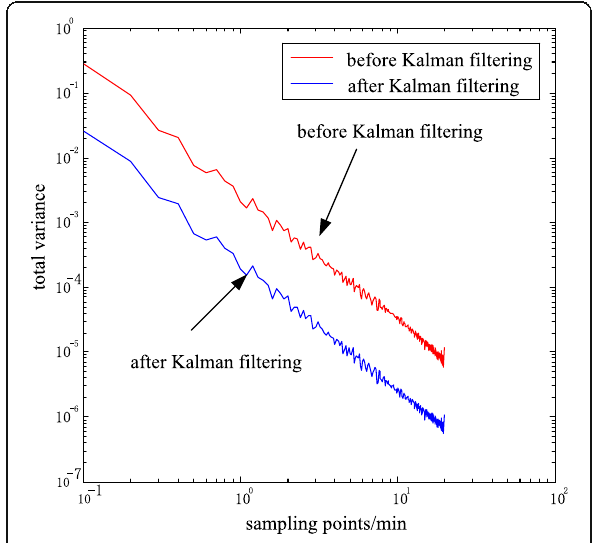
Fig. 5 Total variance analysis before and after Kalman